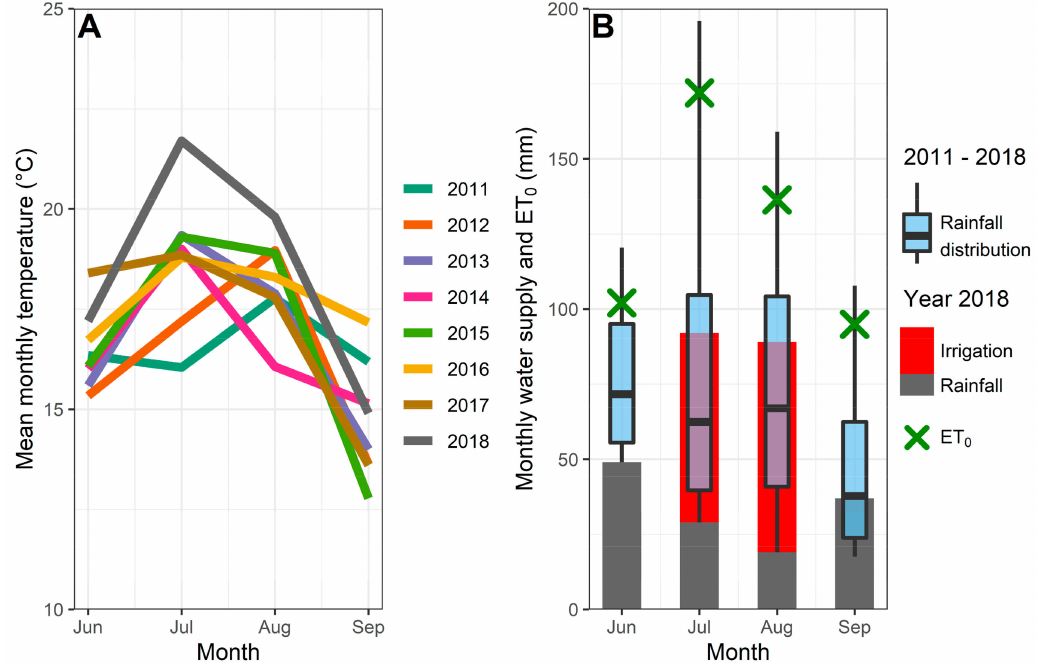
Figure 1. Weather conditions at Campus Klein-Altendorf from 2011 to 2018 for June, July, August, and September. ( A ): Mean monthly temperature ( ◦ C) for each year. ( B ): Precipitation, irrigation, and reference evapotranspiration (ET 0 , in mm, indicated by green crosses). In B, boxplots correspond to the distribution of monthly precipitation for the period 2011–2018. Grey bars represent the precipitation for the year 2018, whereas red sections correspond to the additional water supplied by irrigation in July and